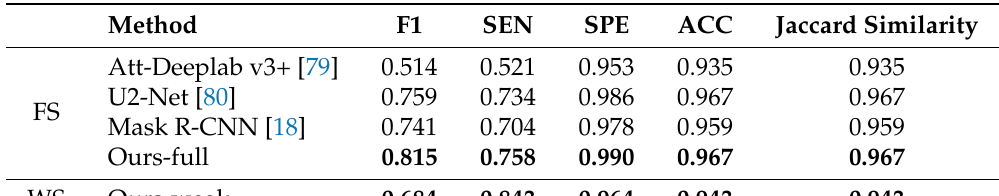
Table 1. Performance comparison of the proposed segmentation network and other methods on the Oral leukoplakia dataset.